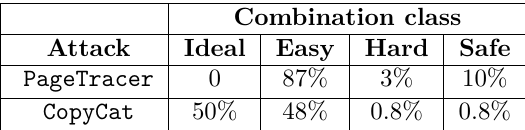
Table 1: libgcrypt OTA classification for 2 17 − 1 page combinations.